Question: What style of plot is this figure drawn as?
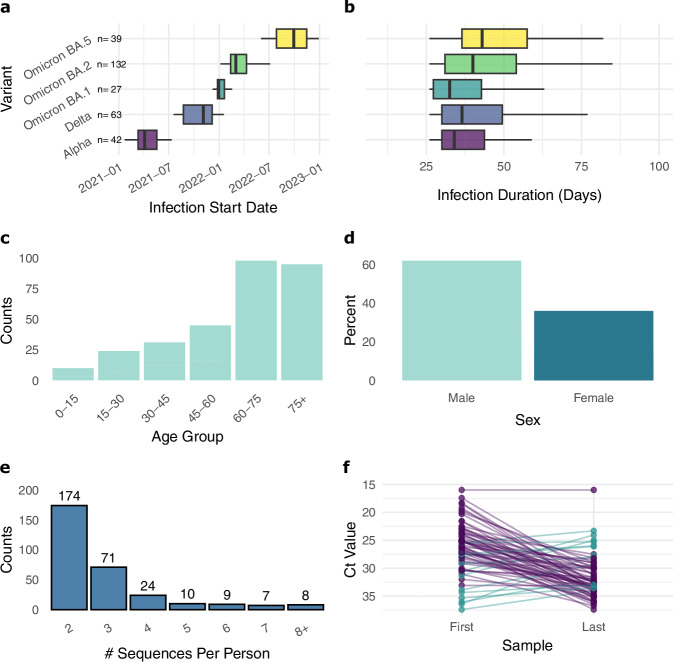
Answer: box